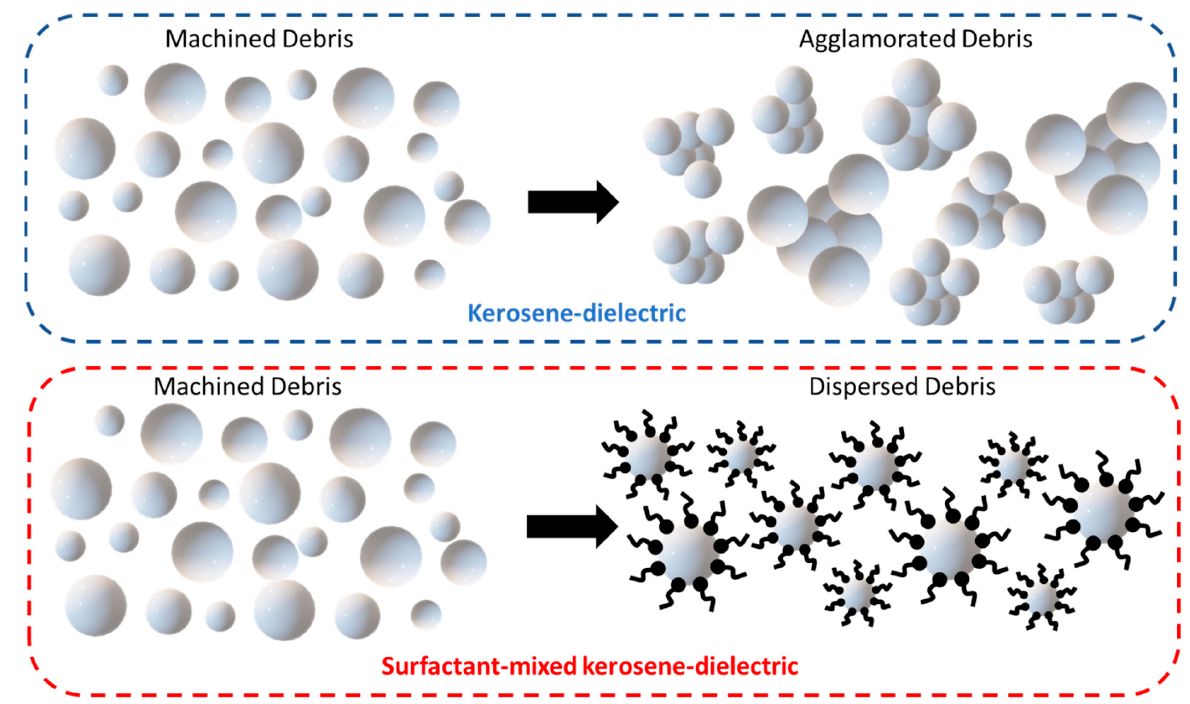
Figure 12. The agglomeration and dispersion phenomena of debris using kerosene dielectric vs. surfactant-mixed kerosene dielectric.